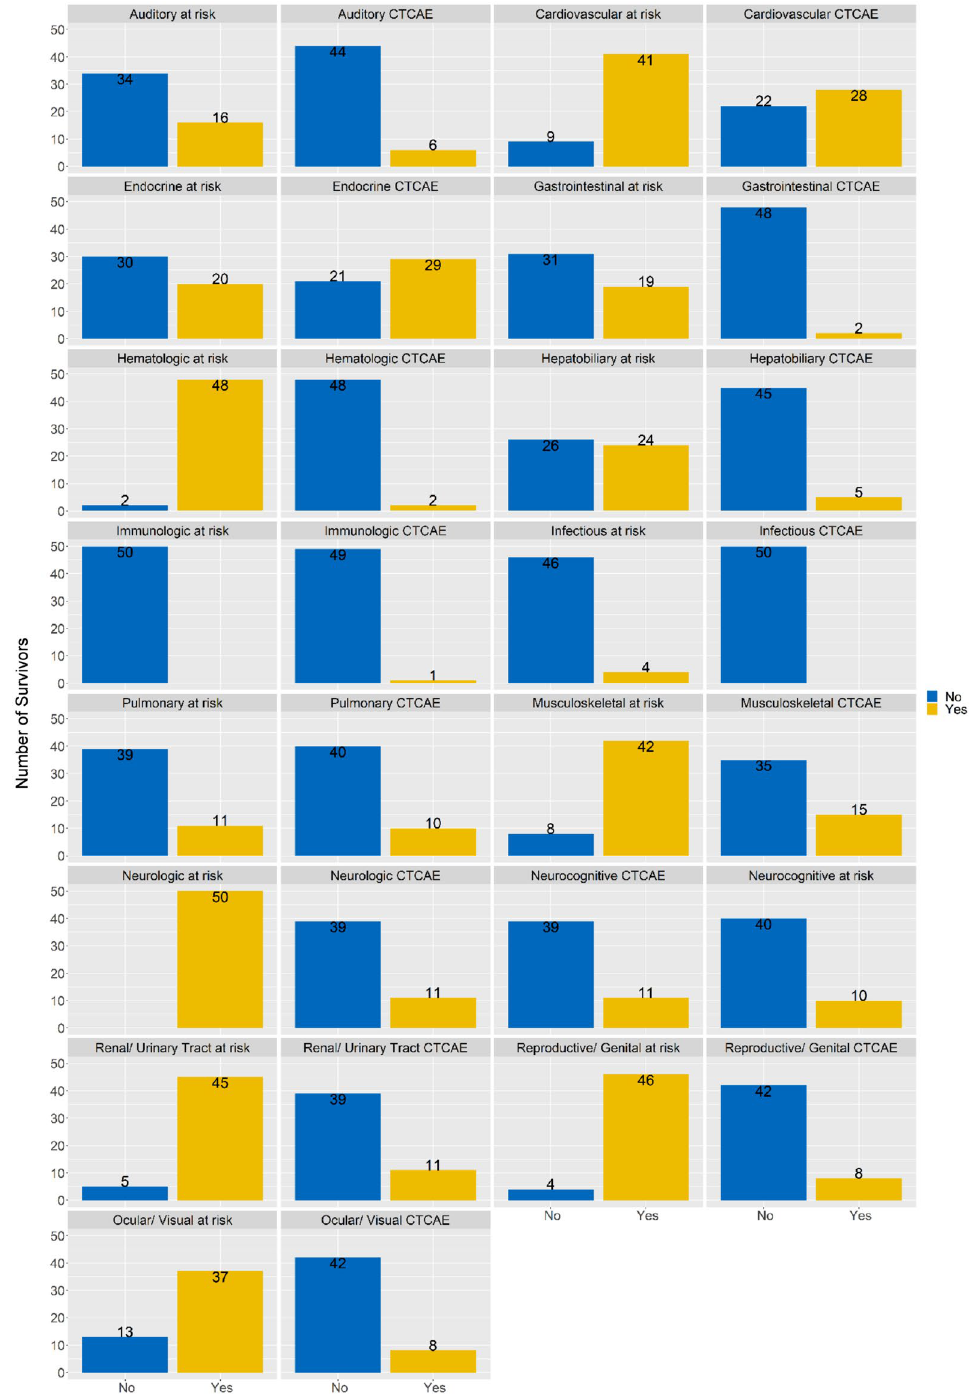
Figure 1. Number of childhood cancer survivors at risk (column 1 and 3) and diagnosed according to CTCAE criteria (column 2 and 4) with a medical condition at their last follow-up visit. X-axis: yellow = at risk or diagnoses with a condition (“yes”), blue = not at risk or not diagnosed with a condition (“no”). Y-axis: number of survivors. Being at risk defined by COG survivorship